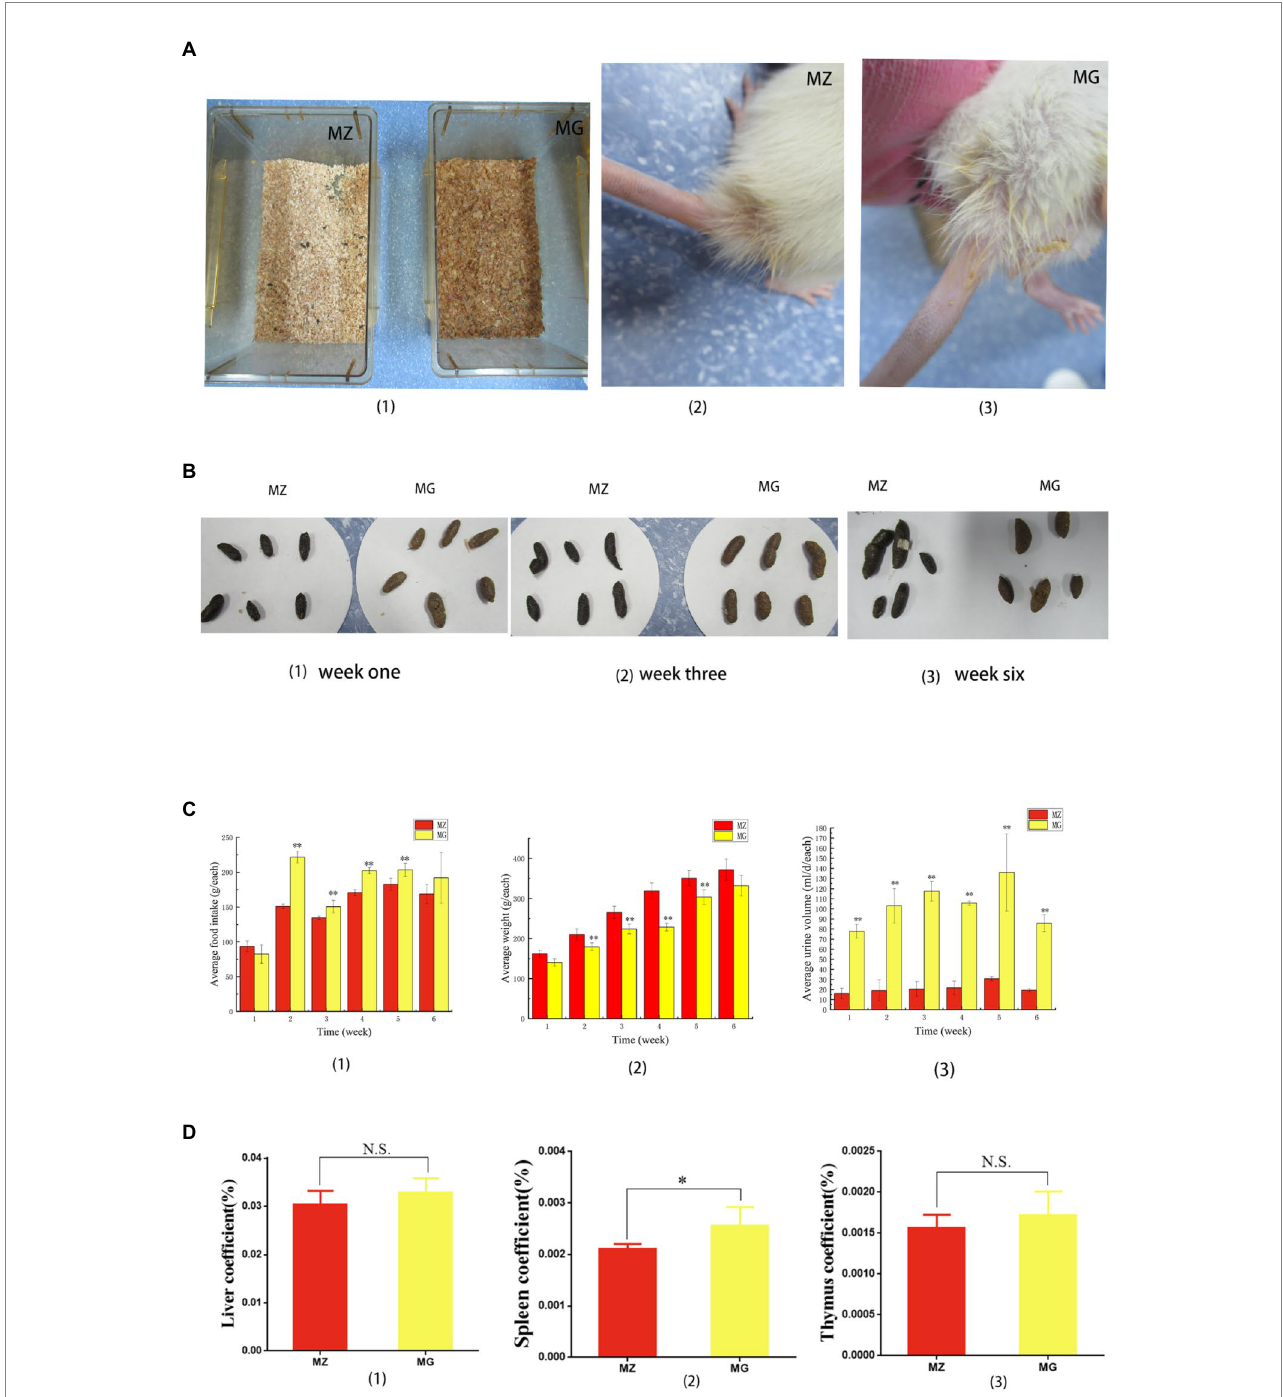
FIGURE 1 High-salt diet induced behavioral and organ coefficient changes in rats. (A) (1) Sawdust bedding material of rats in MZ group and MG group, (2, 3) showed the tail of rats in MZ group and MG group, respectively. (B) Feces of rats in MZ and MG groups at week one (1), week three (2), and week six (3). (C) Changes in food intake (1), body weight (2), and urine output (3) during hypertension induced by high-salt diet in MZ and MG groups. (D) Liver coefficient (1), spleen coefficient (2) and kidney coefficient (3) of rats in MZ and MG groups. MZ, normal group, MG, hypertensive group. (A–D) * p < 0.05, ** p < 0.01; N.S., not significant ( p >